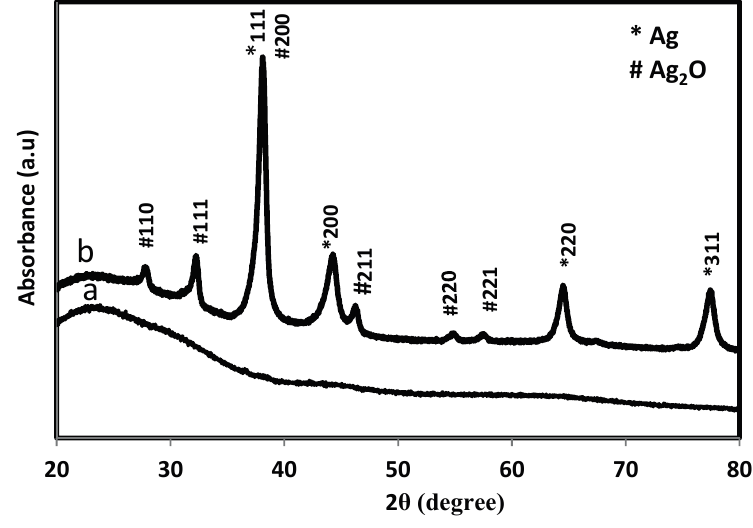
Figure 3. XRD pattern of Sumac ( a ) and bio-formed NPs ( b